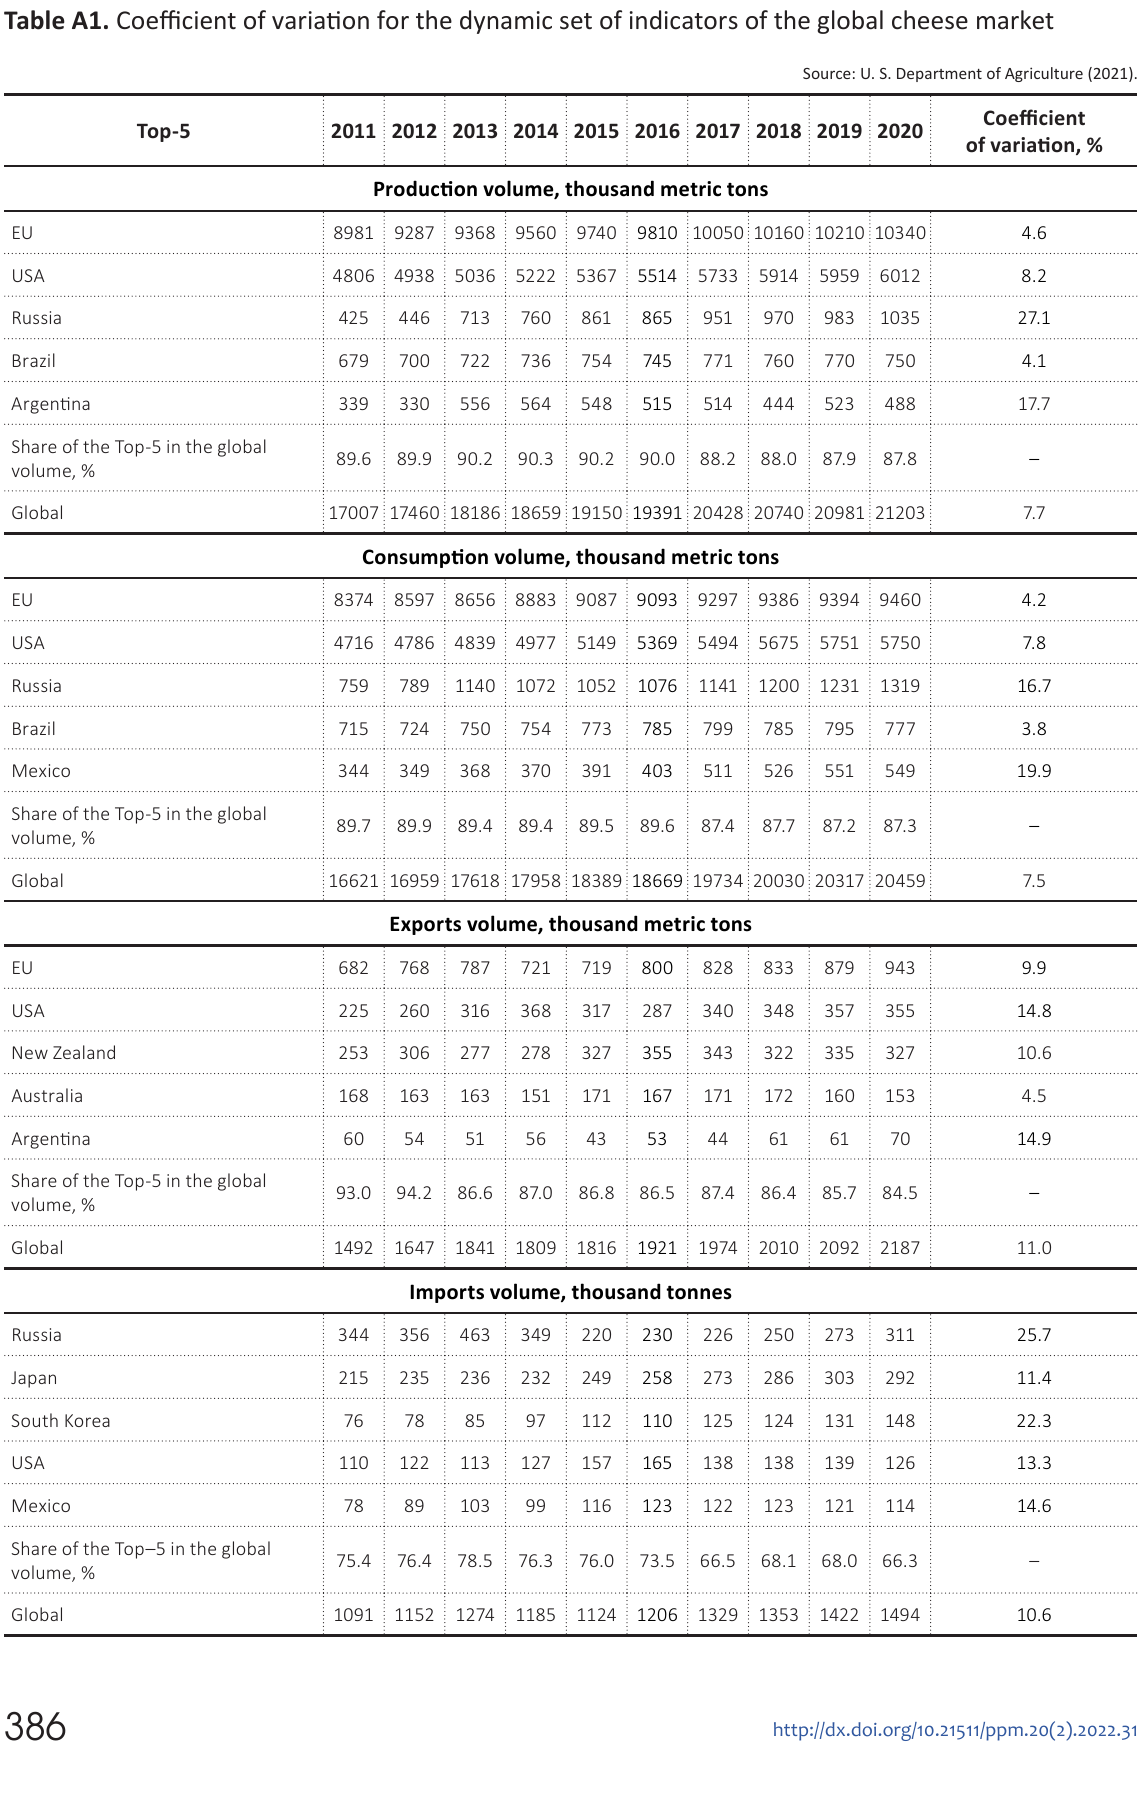
Table A1. Coefficient of variation for the dynamic set of indicators of the global cheese market